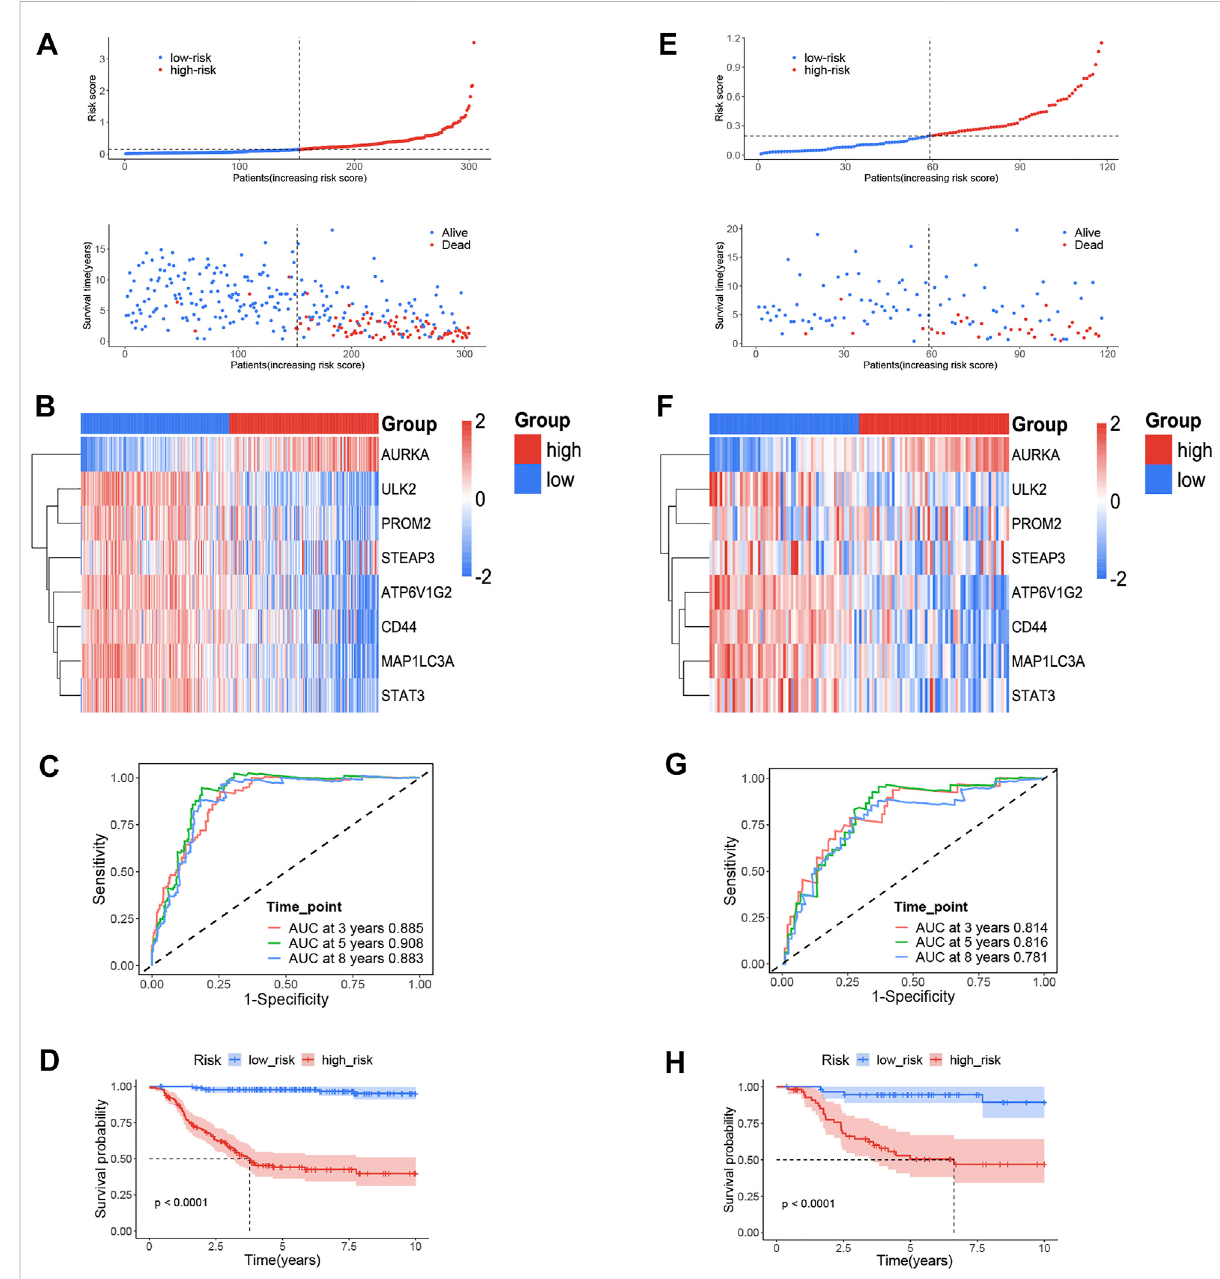
FIGURE 2 The ferroptosis-related genes (FRGs) prognostic signature for NB. (A) The distribution and median value of the risk scores and survival status of patients in the training cohort. (B) Heatmap of the FRG expression pattern in the training cohort. (C) Time-dependent ROC curves veri fi ed the prognostic value of the FRG signature in the training cohort. (D) Kaplan – Meier curves for the OS of patients in the high-and low-risk group in the trainingcohort. (E) Thedistributionandmedianvalueoftheriskscoresandsurvivalstatusofpatientsinthevalidationcohort. (F) Heatmapofthe FRG expressionpattern in the validation cohort. (G) Time-dependent ROC curves veri fi edthe prognostic valueof theFRG signature in the validation cohort. (H) Kaplan – Meier curves for the OS of patients in the high- and low-risk group in the validation cohort.